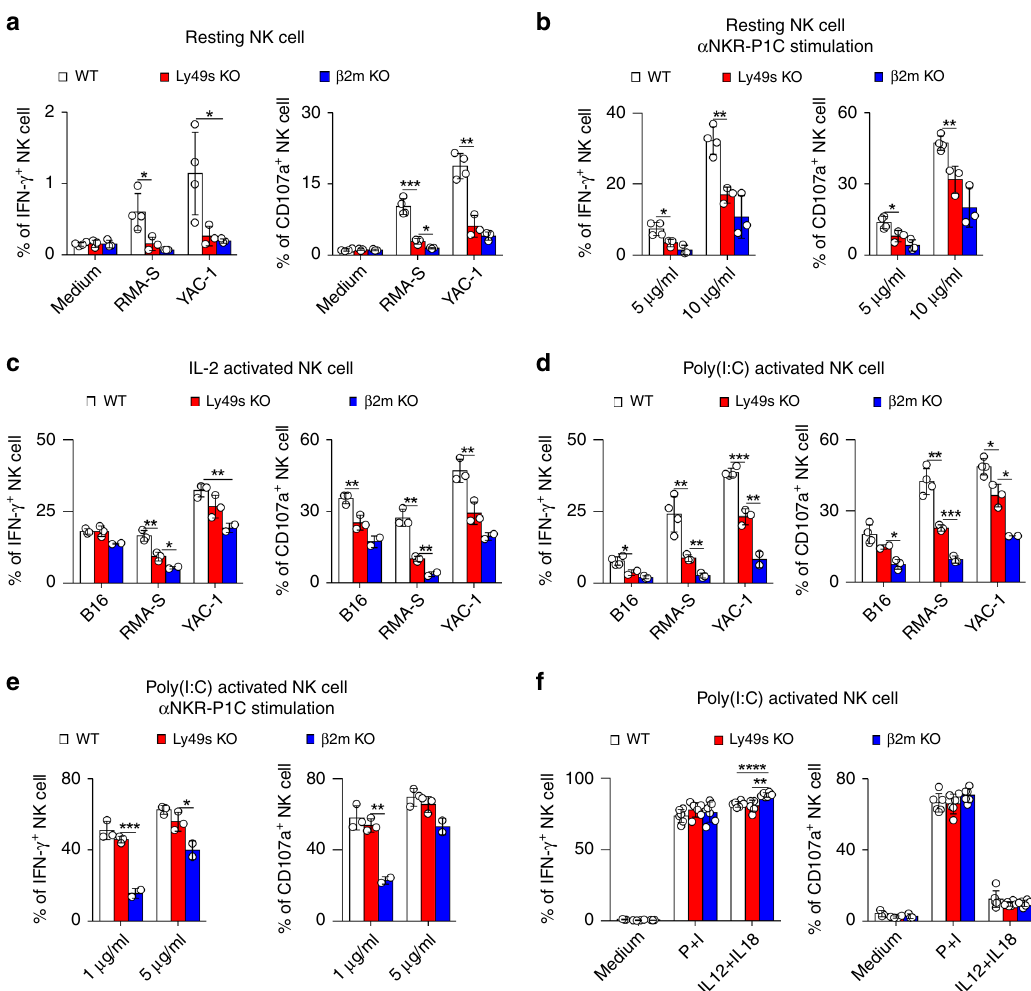
Fig. 2 Ly49 family-de fi cient mice display moderate defect in NK-cell activity in vitro. a Resting splenocytes from the indicated mice were stimulated with tumour target cells and medium served as the negative control. Percentages of IFN- γ + (left panel) or CD107a + (right panel) gated CD3 − NKp46 + NK cells were analysed. b Similar to ( a ), but cells were stimulated with different concentrations of plate-bound antibody against NKR-P1C (clone PK136). c Similar to ( a ), but NK cells were pre-cultured with IL-2 for 5 days. d – f Poly(I:C)-primed splenocytes from the indicated mice were stimulated with the indicated stimuli, tumour target cells ( d ), plate-bound anti-NKR-P1C antibody ( e ) and phorbol-12-myristate-13-acetate (PMA) plus ionomycin (P + I) and IL12 plus IL18 ( f ). Medium served as the negative control. Percentages of IFN- γ + (left panel) and CD107a + (right panel) gated CD3 − NKp46 + NK cells were analysed. Each symbol represents an individual mouse. Data shown represent two ( c , f ) or at least three ( a , b , d , e ) independent experiments. Mean± SD is shown. * p < 0.05, ** p < 0.01, *** p < 0.001 and **** p < 0.0001. Unpaired Student ’ s t -tests (two-tailed) was used to calculate these values. Source data